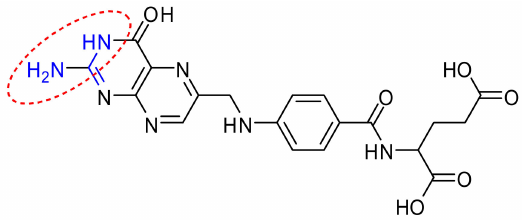
Figure 1. Folic acid reaction